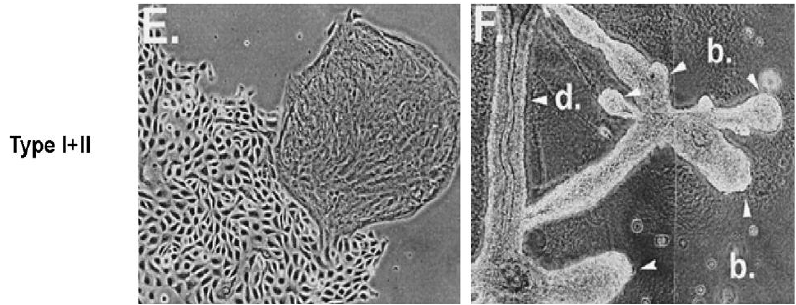
Figure 8. Human breast epithelial cell (HBEC) colonies on plastic and organoids on Matrigel formed from two types of normal HBECs. Type 1 and Type II colonies developed on plastic (( A , C ), respectively) are morphologically distinguishable. On Matrigel, Type II cells typically formed a spherical organoid (s.o.) ( D ), whereas Type I cells formed a limited number of bud-like ( B ) structures and ascini. The combination of Type I and Type II cells (( E ); two types of cells on plastics) in 1:2 or 1:3 ratios can generate many budding ( B ) ductal ( D ) structures in Matrigel ( F ) in 2–3 weeks. Credit to Sun et al. [82].